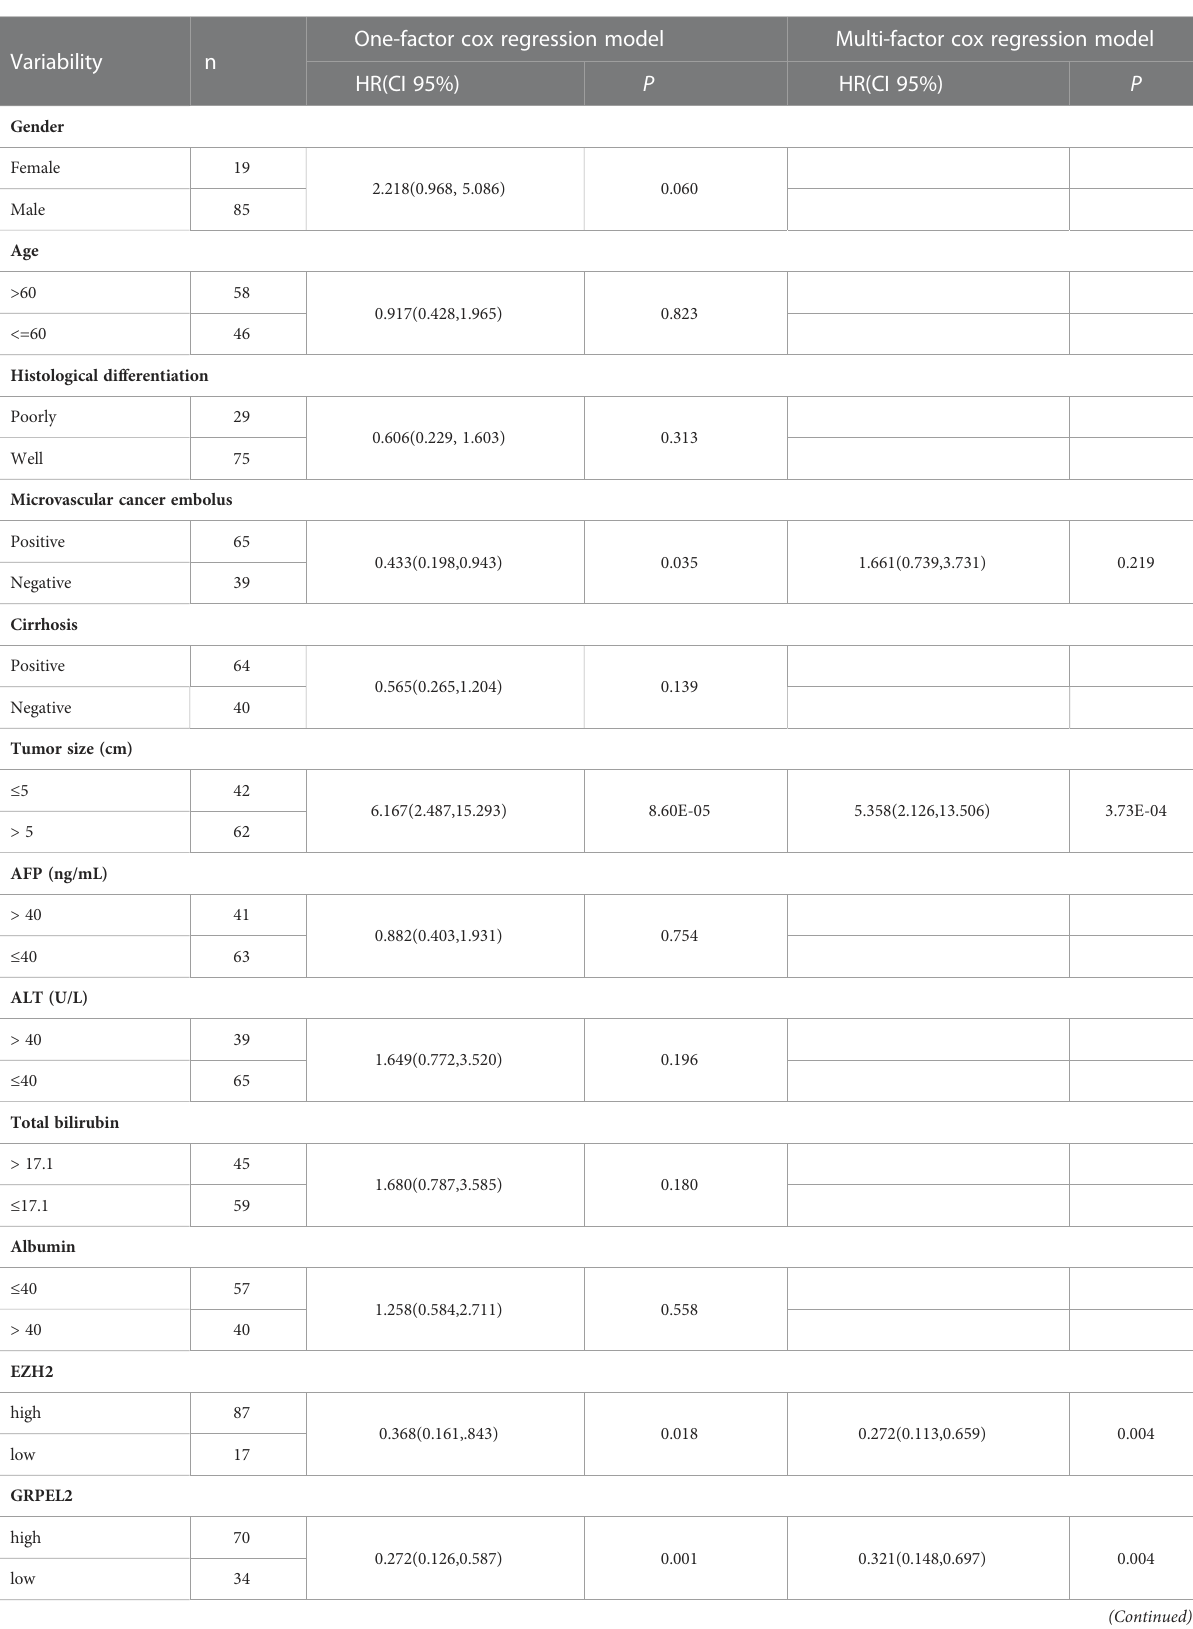
TABLE 3 Survival analysis combined with clinical parameter by